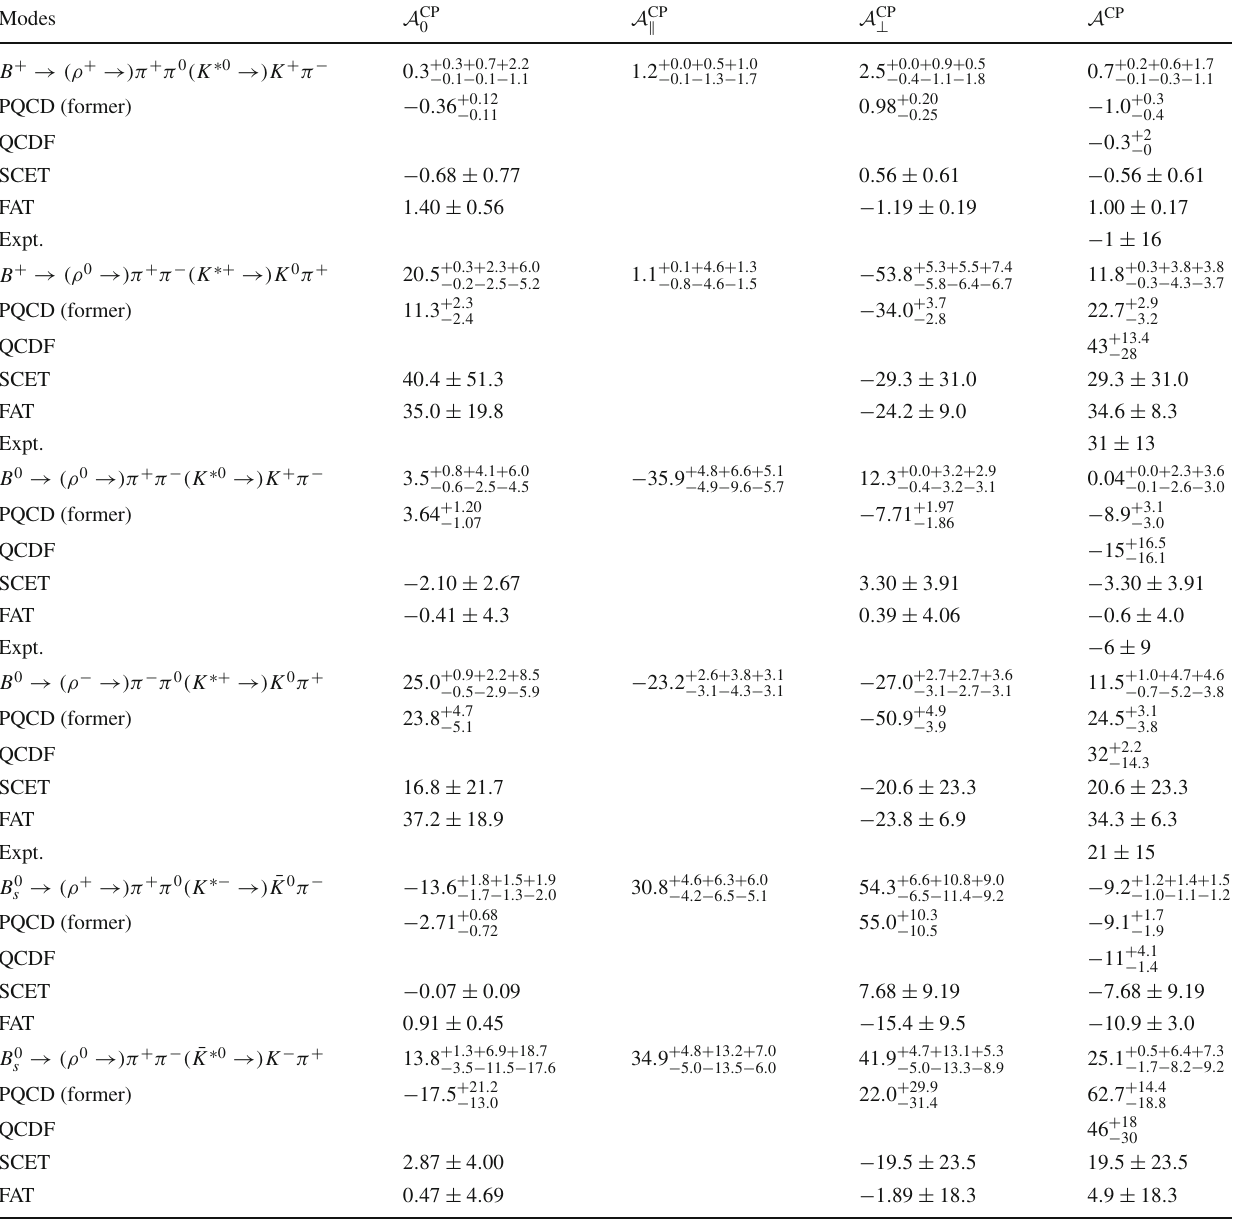
Table 6 Direct CP asymmetries (in units of %) for the B ( s ) → V V → and FAT [26]. Experimental results for branching ratios are taken from (ππ)( K π) decayscomparedwiththepreviouspredictionsinthePQCD Table 2. The sources of the theoretical errors are the same as in Table 4 approach [18], the updated predictions in the QCDF [3,4], SCET [25] A CP Modes A CP 0